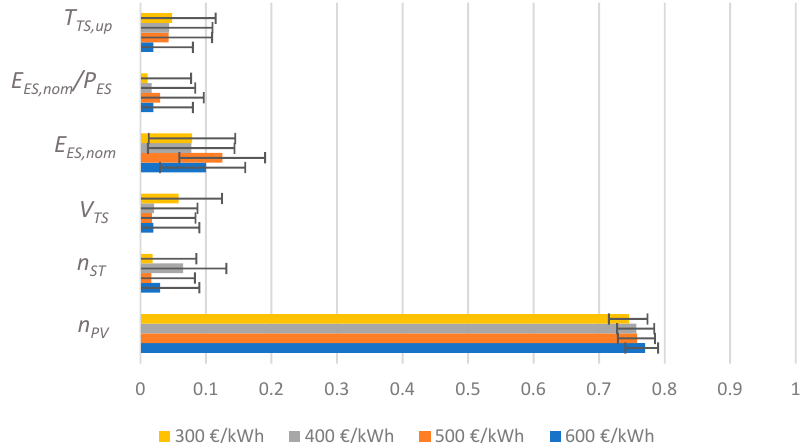
Figure 16. Correlation coefficient between the design variables and the No-RES (renewable energy sources) primary energy consumption, depending on ES unitary price.